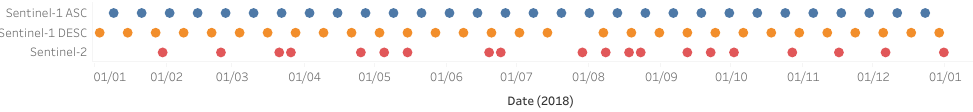
Figure 3. Temporal distribution of the images used from both satellites, Sentinel-2 and both orbits from Sentinel-1 throughout